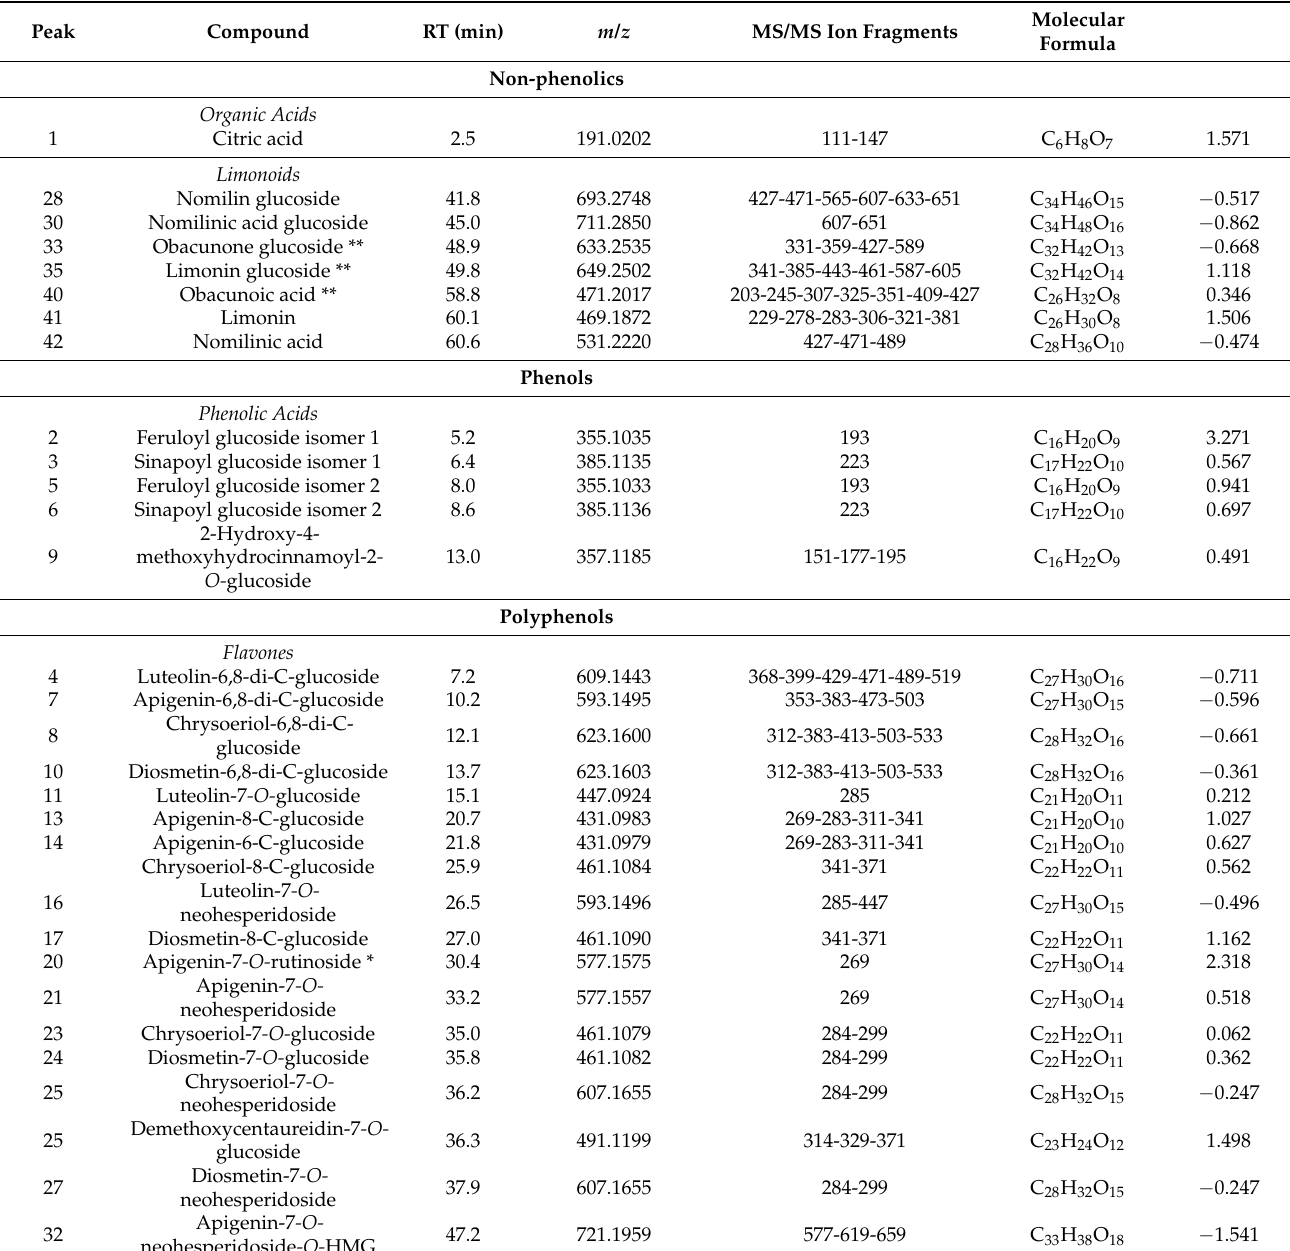
Table 1. Compounds identified in both BFPF and BLPF with the targeted approach. * only present in the BLPF. ** only present in